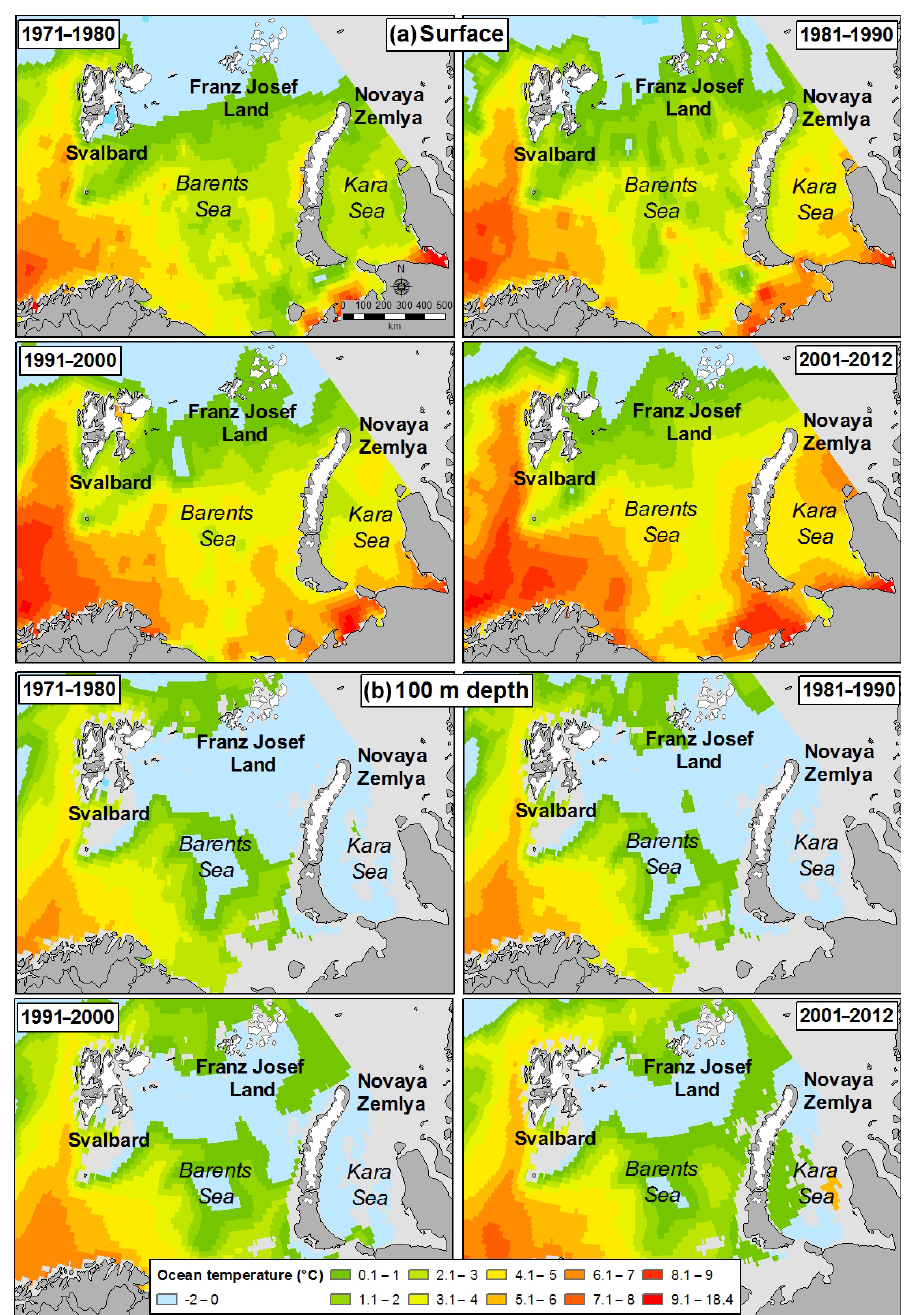
Figure 9. Ocean temperatures from the “Climatological Atlas of the Nordic Seas and Northern North Atlantic” (Korablev et al., 2014) at (a) the surface and (b) 100m depth for the following time intervals: 1970–1981, 1981–1990, 1991–2000, and 2001–2012. These intervals were chosen to match as closely as possible with the glacier frontal-position data and other data sets. Note that data coverage was substantially lower for 2001–2012 than for other time periods. Further details on data coverage are available here: https://www.nodc.noaa.gov/OC5/